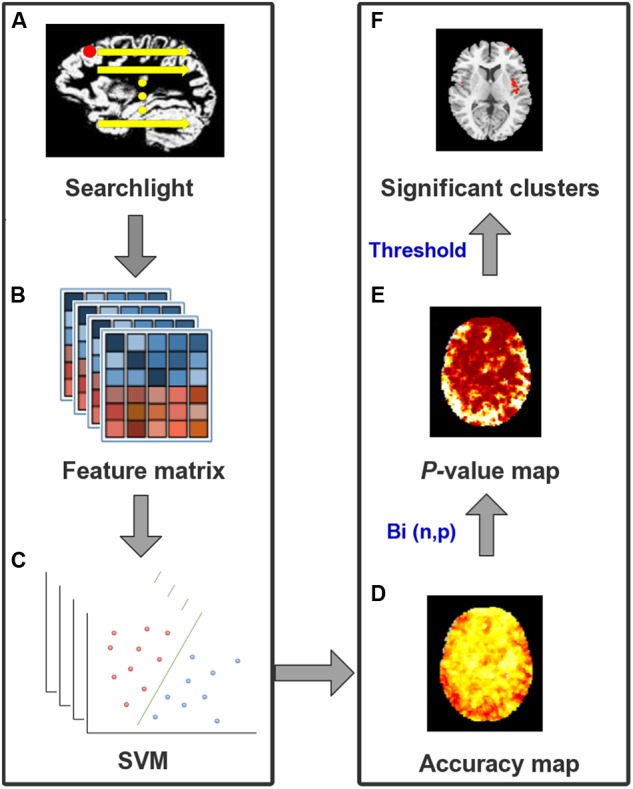
The flowchart for MVPA procedure. (A) For each voxel in GM as a center, a 5-mm sphere was defined as a searchlight. (B) GM volumes of all voxels in the same sphere were extracted from all subjects to construct a feature matrix. (C) SVM classifier with LOOCV was built to produce an accuracy value for the central voxel. (D) This procedure was repeated after the whole brain accuracy map was created. (E) Binominal distribution, with a null hypothesis that there were no differences between two groups, was tested to convert the accuracy map into a p-value map. (F) With a threshold of p < 0.0001 and cluster size >50 voxels, significant clusters to classify different groups were identified finally.